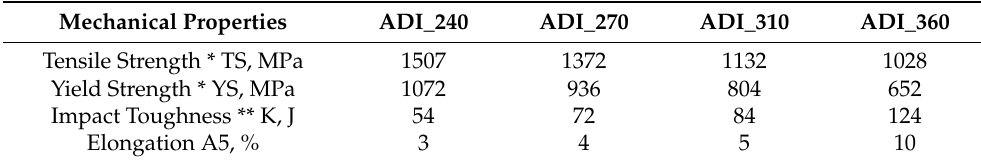
Table 3. Mechanical properties of the tested ADI [28]. Mechanical